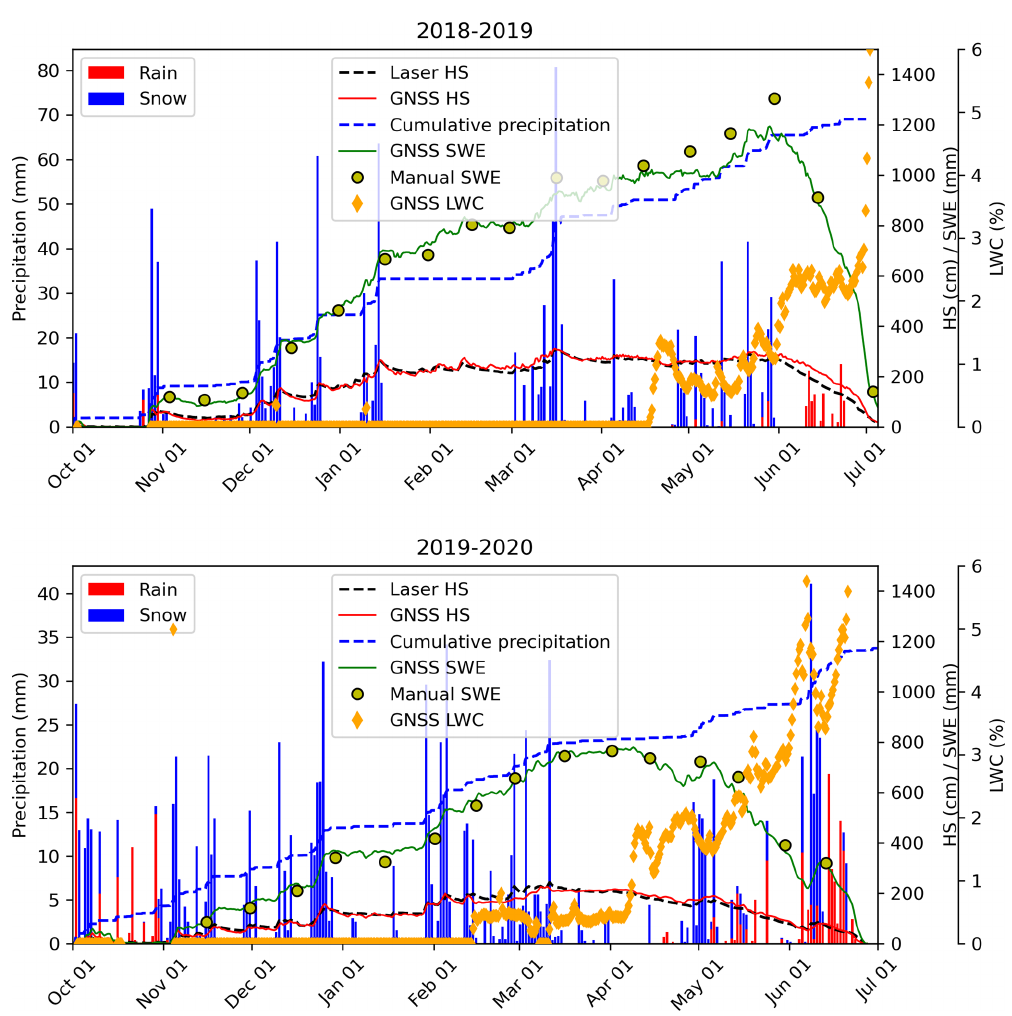
Figure B2. Seasonal evolution of GNSS-derived SWE and HS and corresponding reference data for Weissfluhjoch. The blue columns correspond to precipitation in the form of snow; the red columns correspond to rain. Reference precipitation was measured by a pluviometer and classified as rain for air temperature T > 1.1 ◦ C and as snow for T ≤ 1.1 ◦